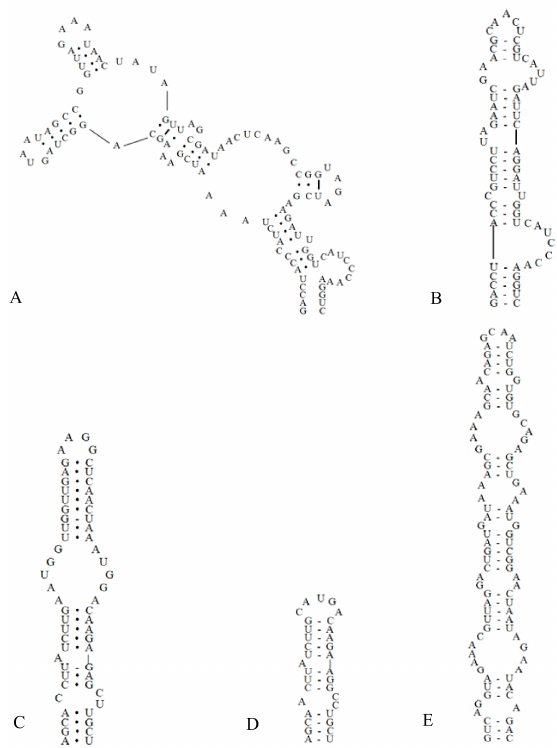
Figure 4. Secondary structures of the 16S–23S ITS region in Cartusia hunanesis and Cartusia fontana . ( A ). D1–D1 ′ helix of Cartusia fontana Kovacik 1999/1. ( B ). D1–D1 ′ helix of Cartusia hunanesis ZJJ02 and ZJJ03. ( C ). Box–B helix of Cartusia fontana Kovacik 1999/1. ( D ). Box–B helix of Cartusia hunanesis ZJJ02 and ZJJ03. ( E ). V3 helix of Cartusia hunanesis ZJJ02 and ZJJ03.